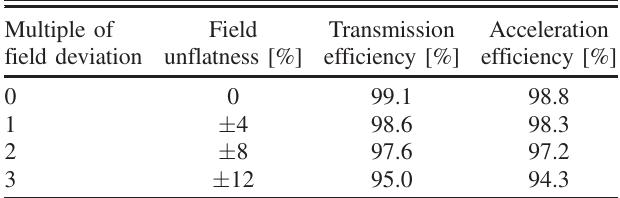
TABLE VII. The transmission and accelerating efficiency with different multiples of the field deviation.